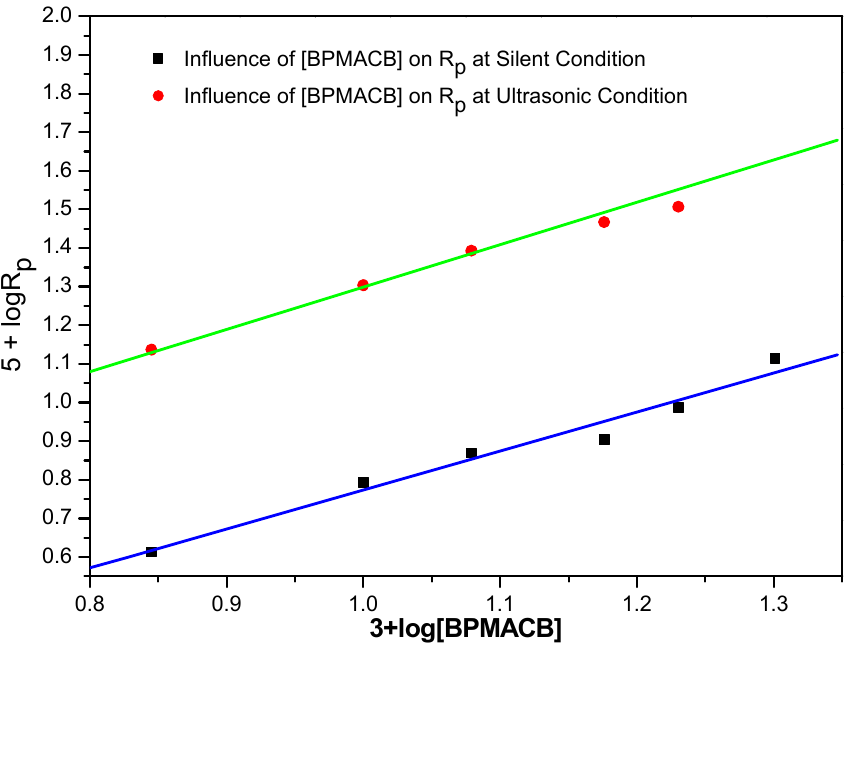
Figure 6. Bi-logarithmic plot illustrating the influence of BPMACB concentration on the for the polymerization of MABE under US-MPTC and Silent-MPTC conditions: R p 2.00 × 10 − 2 mol·dm − 3 of PPS, 3.0 mol·dm − 3 of MABE, 0.3 mol·dm − 3 of [H + ], 0.1 mol·dm − 3 of [µ], 60 °C of temperature (50 kHz, 300 W for ultrasonic assisted